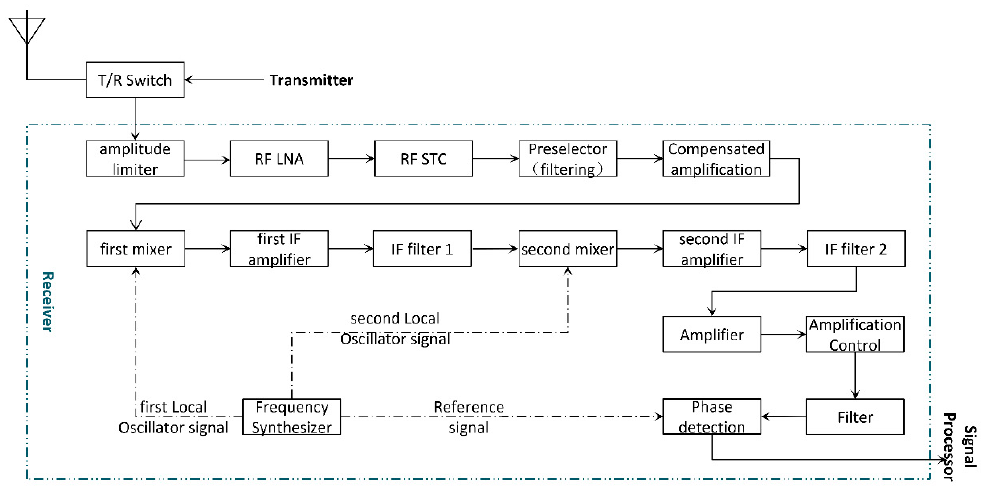
Figure 2. Structure Diagram of a Superheterodyne Receiver.